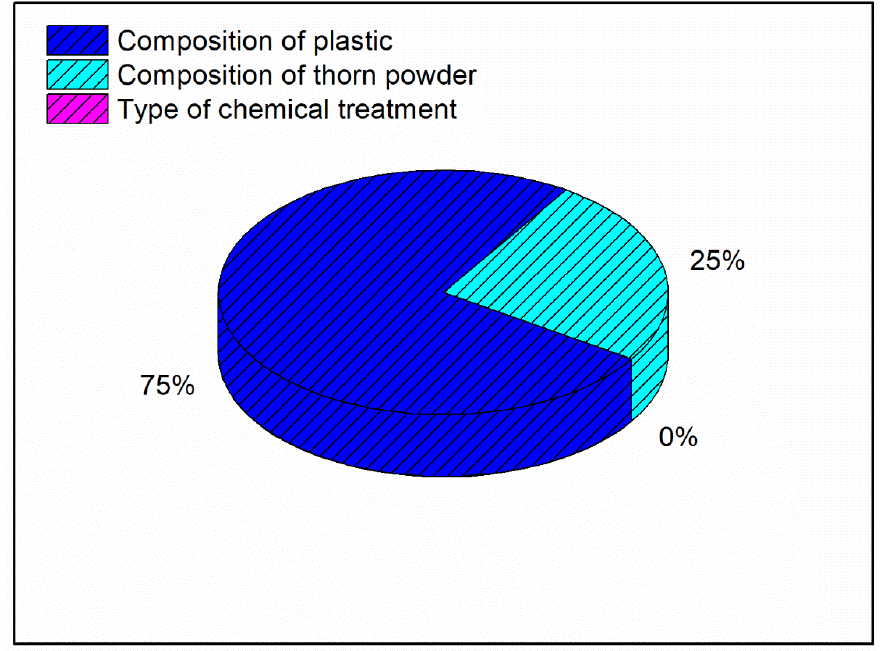
Figure 8. Contribution plot for water